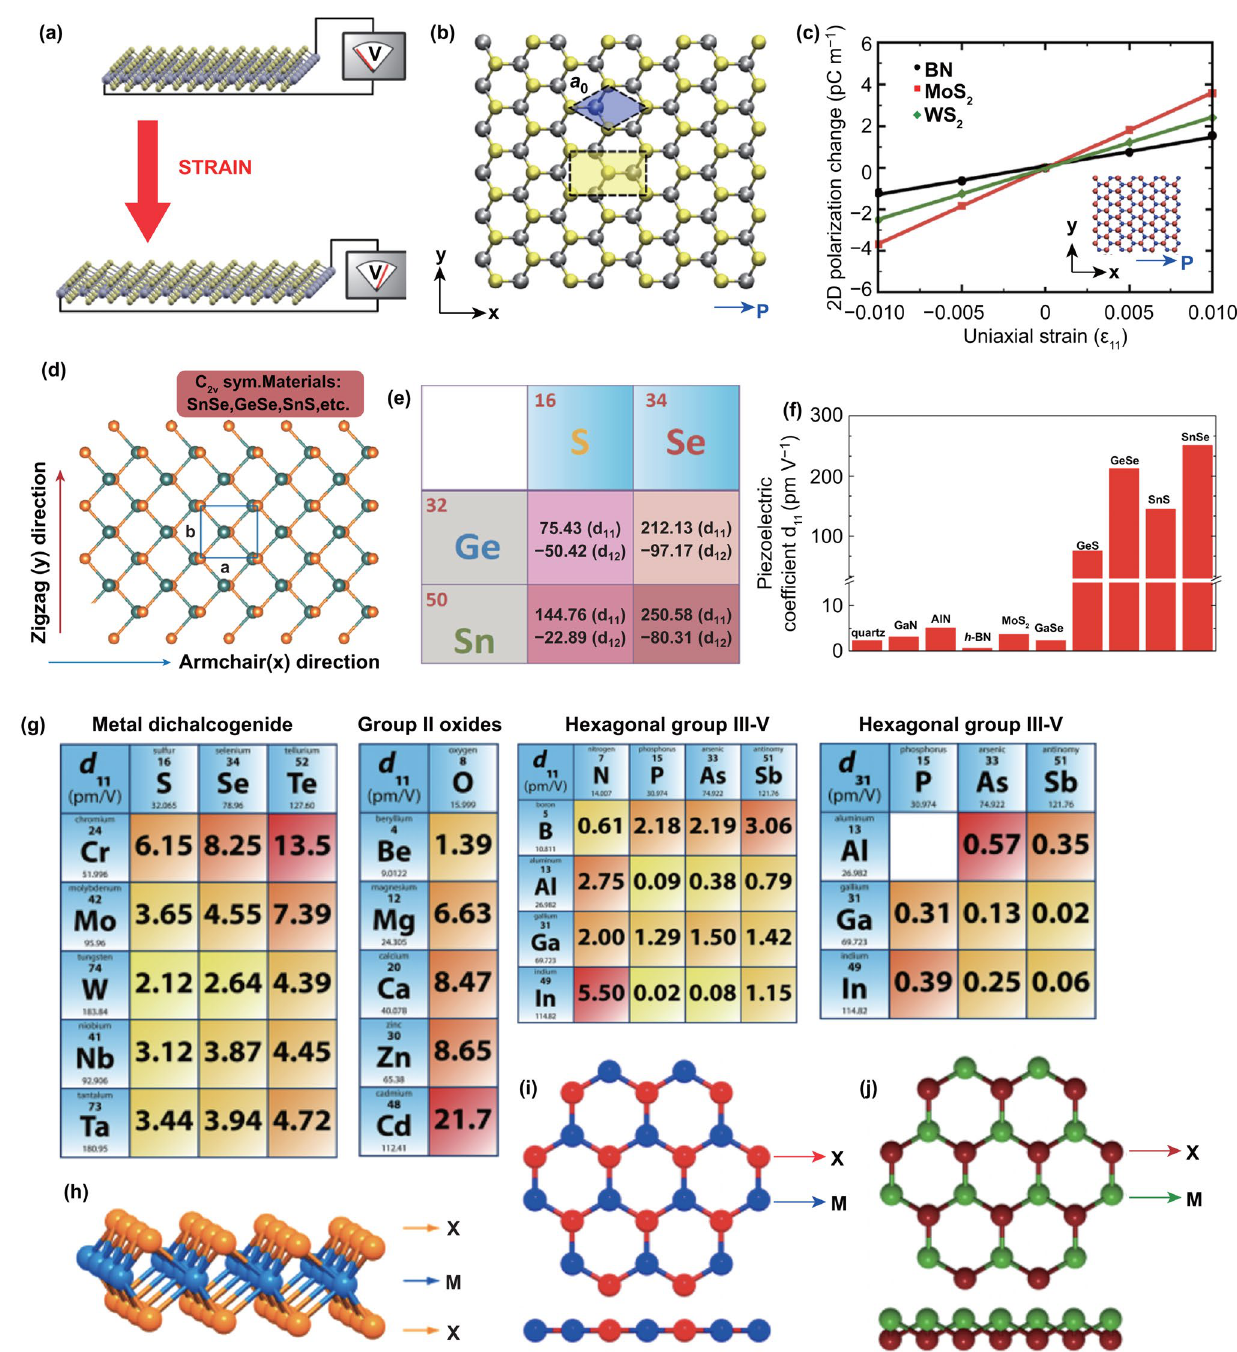
Fig. 3 Simulation studies of in-plane piezoelectric effects in 2D semiconductors. a Schematic diagram of piezoelectric potential generation in monolayer materials. b Monolayer top-view geometry of monolayer 2H-MoS 2 . c Variation of polarization induced by strain in monolayer materials. Reproduced with permission [73]. Copyright 2012, American Chemical Society. d Top views of the C 2v orthorhombic monolayer. e Calculated piezoelectric coefficients of monolayer group IV monochalcogenides and f comparison of piezoelectric coefficient ( d 11 ) with previ- ously known piezoelectric materials. Reproduced with permission. [77] Copyright 2013, American Chemical Society. g Calculated piezoelectric coefficients of 2D materials. Materials structures are illustrated for h 2H, i planar hexagonal and j buckled hexagonal structures. Reproduced with permission. [91] Copyright 2015, American Chemical